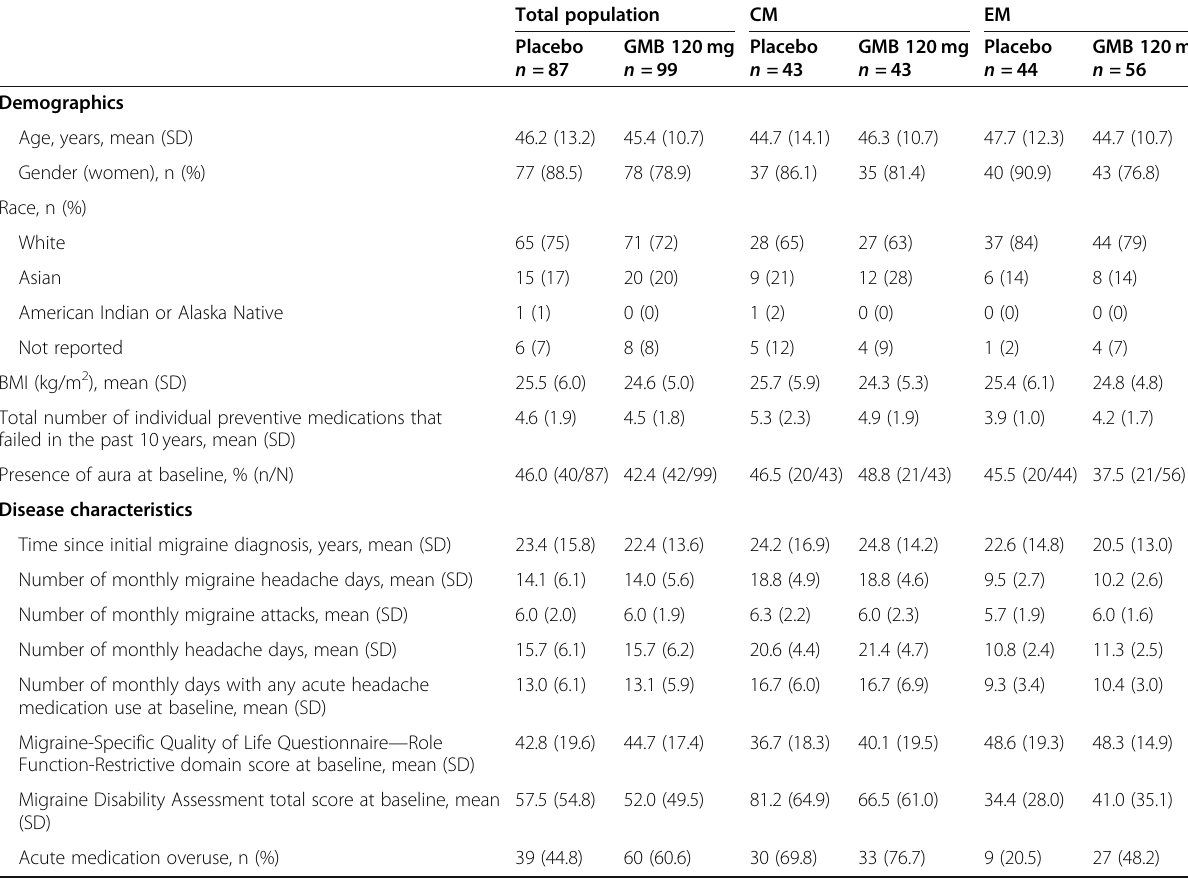
Table 1 Baseline characteristics in patients with chronic migraine or episodic migraine who had failed 3 – 4 preventive medication categories due to inadequate efficacy, or safety or tolerability reasons within the last 10